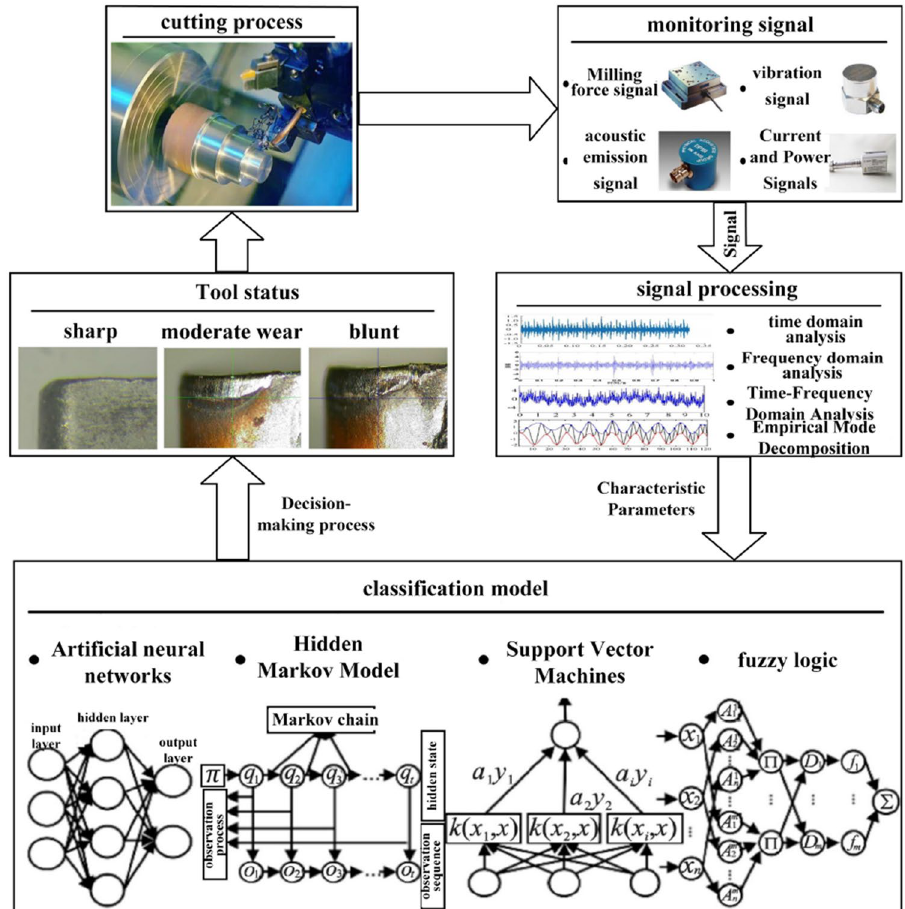
Fig. 5 Flow chart of tool wear monitoring